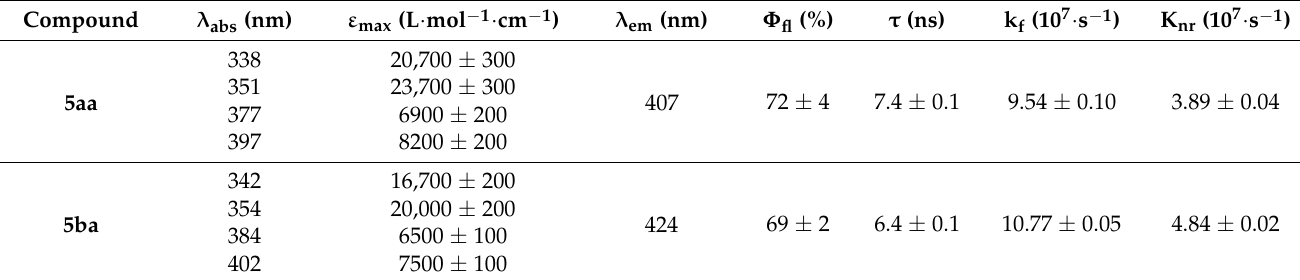
Table 2 . The photophysical properties for the obtained molecules 10 and 11 .